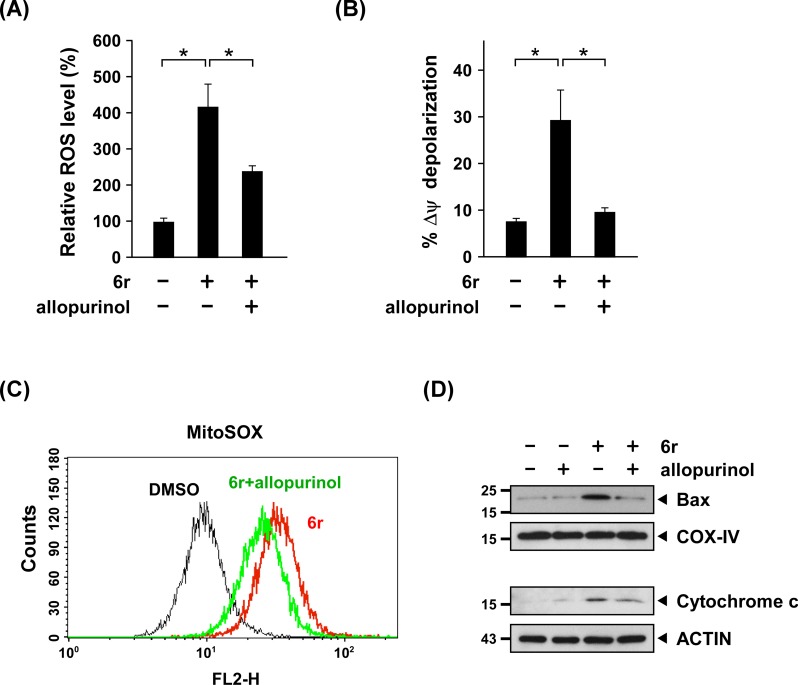
CTSS inhibition-induced early ROS is responsible for mitochondrial damage and the second oxidative burst.(A) For the inhibition of XO-generated early ROS, cells were pretreated with 200 μM of allopurinol for 1 h and cotreated with 20 μM of 6r for an additional 4 h. The intracellular cellular ROS level was determined using DCFH-DA and was quantified by flow cytometry. The data represent the mean ± SD of 3 independent experiments. Differences were found to be statistically significant at *P < 0.05 (B) After pretreatment with 200 μM of allopurinol for 1 h and cotreatment with 20 μM of 6r for an additional 24 h, the mitochondrial membrane potential was determined using JC-1 and quantified by flow cytometry. The data represent the mean ± SD of 3 independent experiments. Differences were found to be statistically significant at *P < 0.05 (C) Reducing the XO-generated early ROS level by allopurinol attenuated mitochondria-specific ROS generation. After pretreatment with 200 μM of allopurinol for 1 h and cotreatment with 20 μM of 6r for 24 h, the mitochondria-specific ROS level was determined using MitoSOX and quantified by flow cytometry. (D) Allopurinol treatment reduces Bax translocation and cytochrome c release in 6r-treated cells. Cells were pretreated with 200 μM of allopurinol for 1 h, and then cotreated with 20 μM of 6r for 24 h. Mitochondrial and cytosolic fractions were prepared and subjected to western blot analysis for cytochrome c, Bax, ACTIN, and COX-IV.